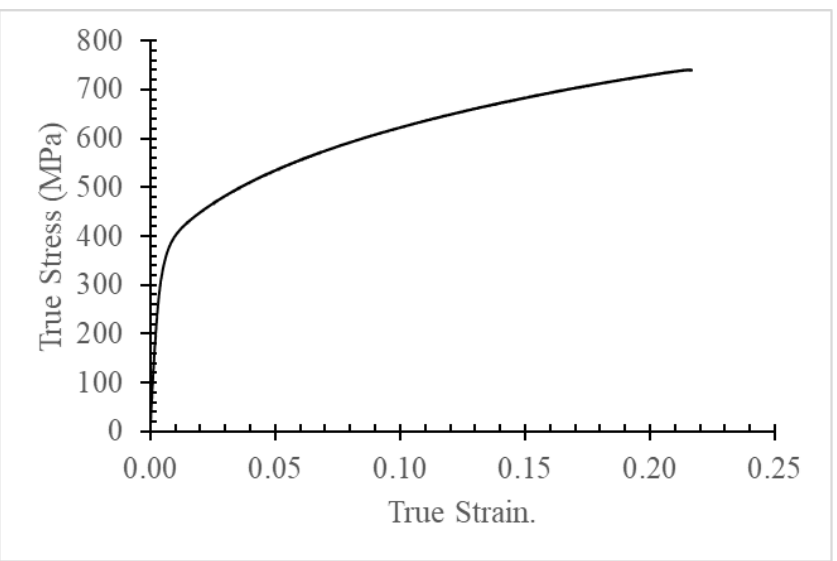
Figure 3. Experimental tensile stress – strain relation of DP600 steel (workpiece material).